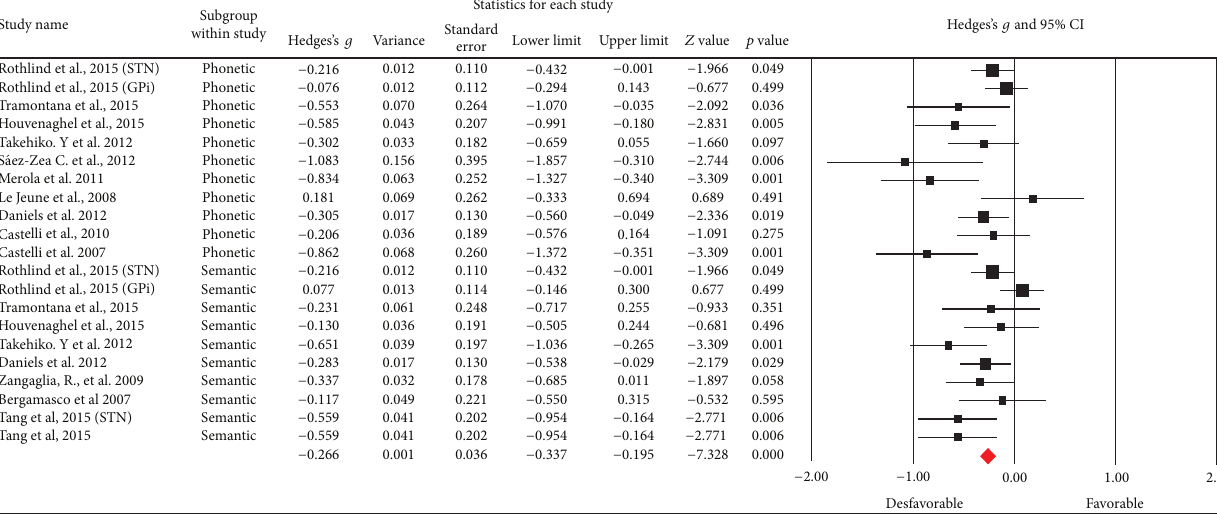
Figure 3: Meta-analysis of verbal fluency comparing before and after DBS surgery. Verbal fluency was separated in phonetic and semantic parts. STN = subthalamic nucleus; GPi = internal globus pallidus.